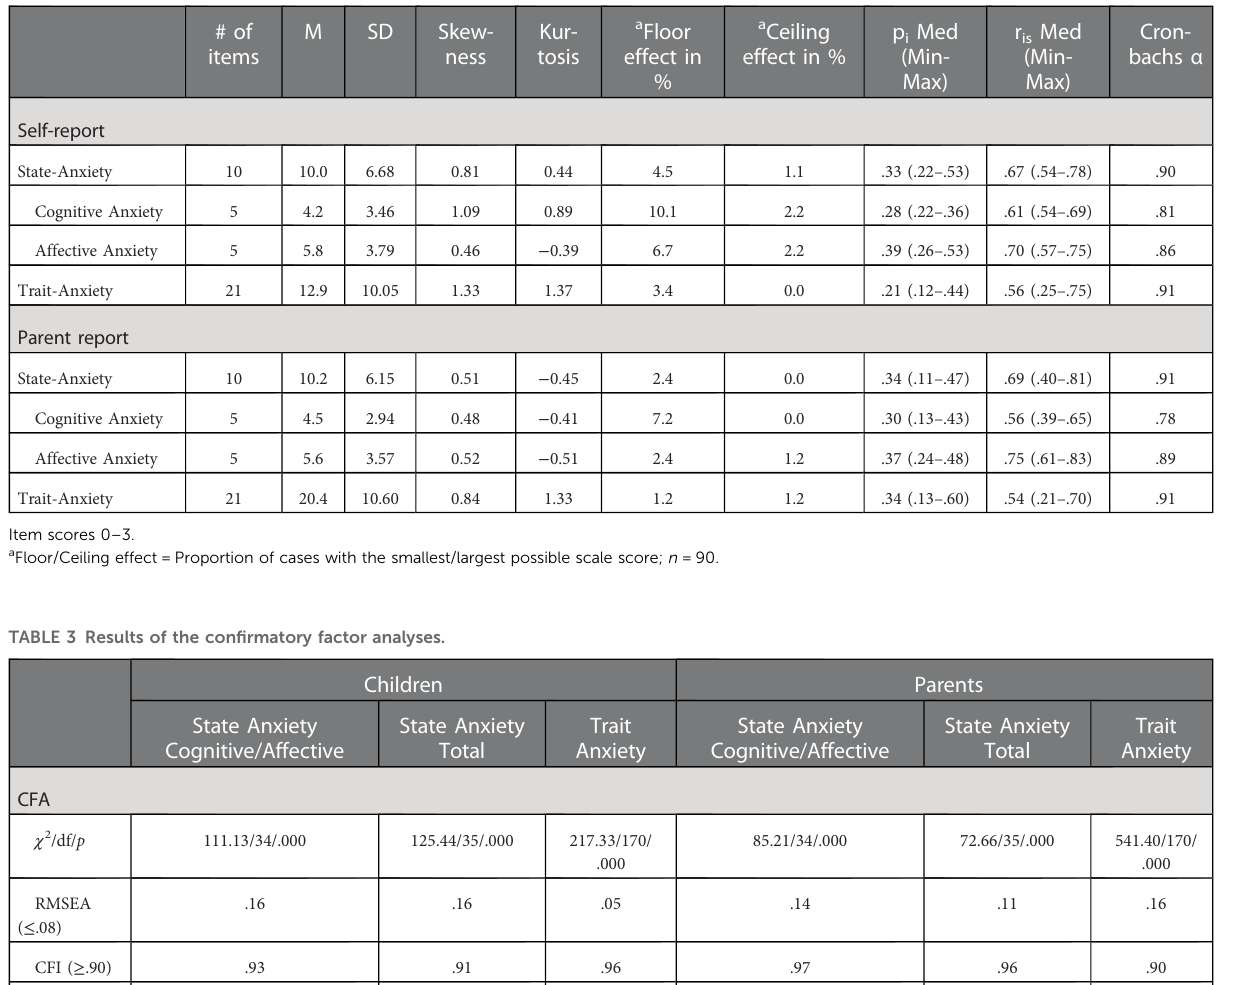
TABLE 2 Summary of item and scale statistics.